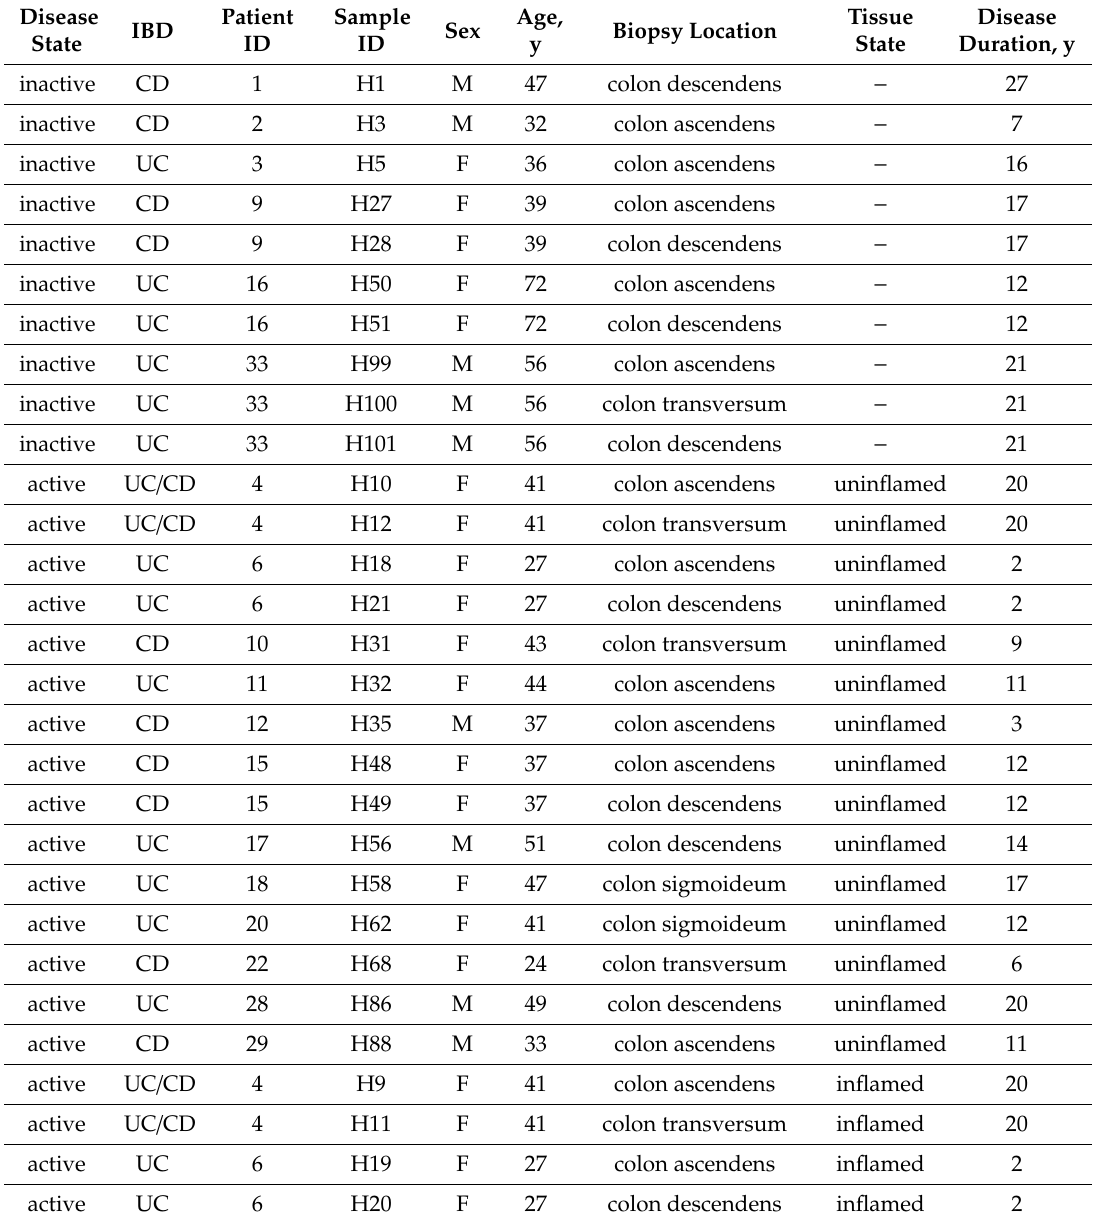
Table 1. Demographic data for study participants. Patient records were reviewed for disease state (inactive, active), tissue state (inflamed, uninflamed), Inflammatory Bowel Disease (IBD) type (Crohn’s Disease, CD; Ulcerative Colitis, UC; IBD indeterminate, UC / CD), biopsy location (colon ascendens / transversum / descendens / sigmoideum), age (year, y), sex (male, M; female, F) and disease duration (year,